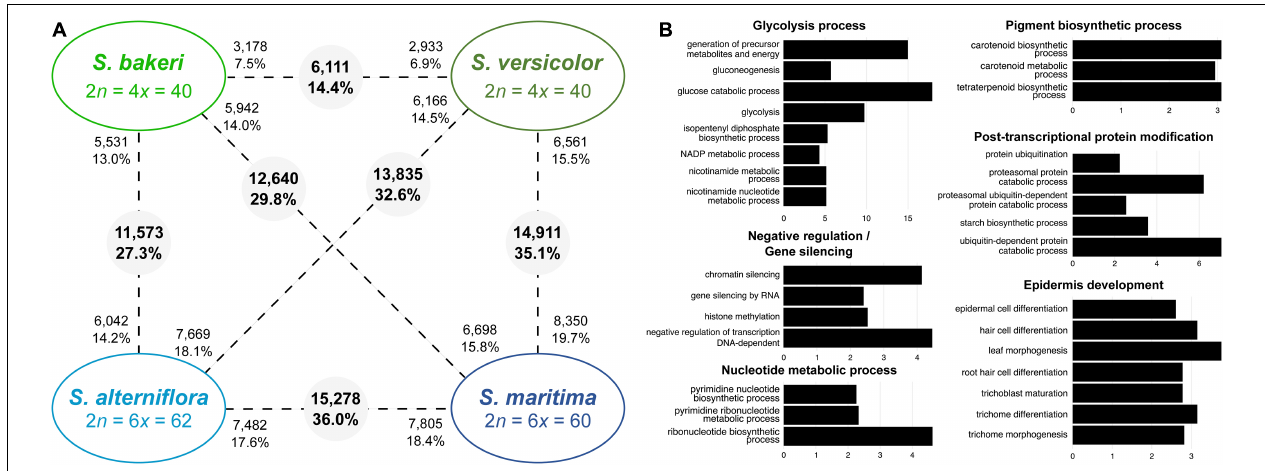
FIGURE 3 | Transcriptomic changes between tetraploids species ( S. bakeri and S. versicolor ) and hexaploid species ( S. alterniflora and S. maritima ). (A) Number of differentially expressed genes between species (pairwise comparisons). The numbers in grey circles represent the number of orthologs differentially expressed among the 42,423 analyzed clusters. The numbers of upregulated orthologs are represented near species names. (B) Bar graph of the most enriched GO-terms (biological process) for the differentially expressed orthologs between tetraploid and hexaploid species. GO-terms were grouped according to their metabolic pathway affiliation. X -axis corresponds to the negative logarithm of adjusted p -value. The complete list of enriched GO terms is available in Supplementary Tables 4 , 5 .